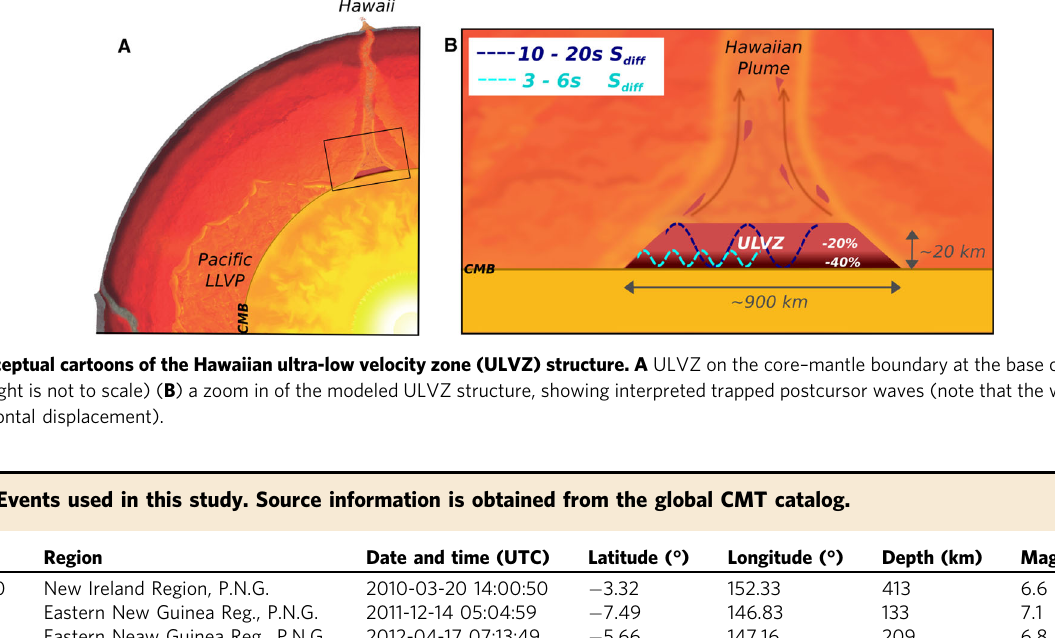
Table 1 Events used in this study. Source information is obtained from the global CMT catalog. Event Region Date and time (UTC) Latitude (°) Longitude (°) Depth (km) Magnitude (M W ) 20100320 New Ireland Region, P.N.G. 2010-03-20 14:00:50 − 3.32 152.33 413 Eastern New Guinea Reg., P.N.G. 2011-12-14 05:04:59 146.83 Eastern Neaw Guinea Reg., P.N.G. 2012-04-17 07:13:49 South Of Kermadec Islands 2018-05-18 01:45:31 North Island, New Zealand 2018-10-30 02:13:39 North Island, New Zealand 2016-11-22 00:19:43 Kermadec Islands Region 2018-09-10 04:19:02